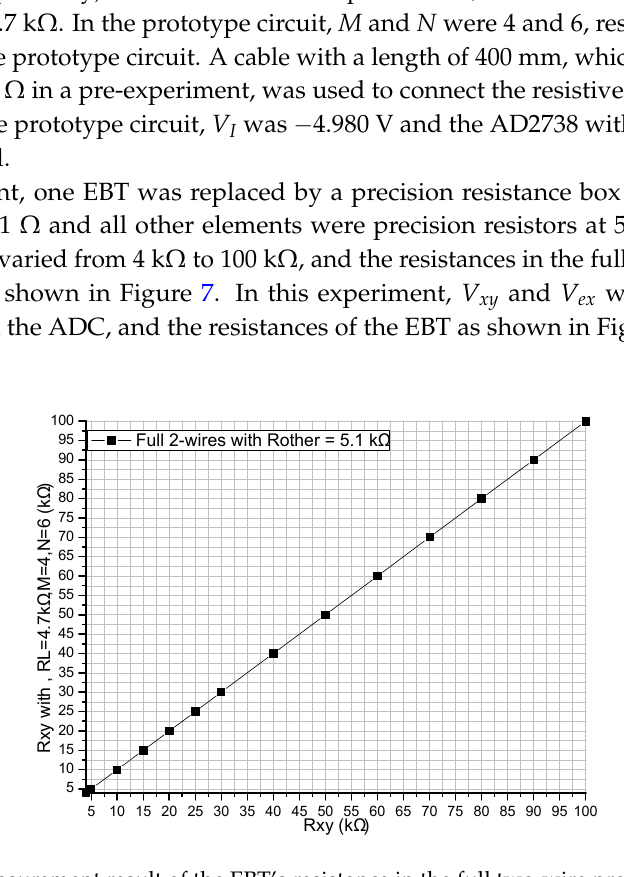
Figure 7. Measurement result of the EBT’s resistance in the full two ‐ wire prototype